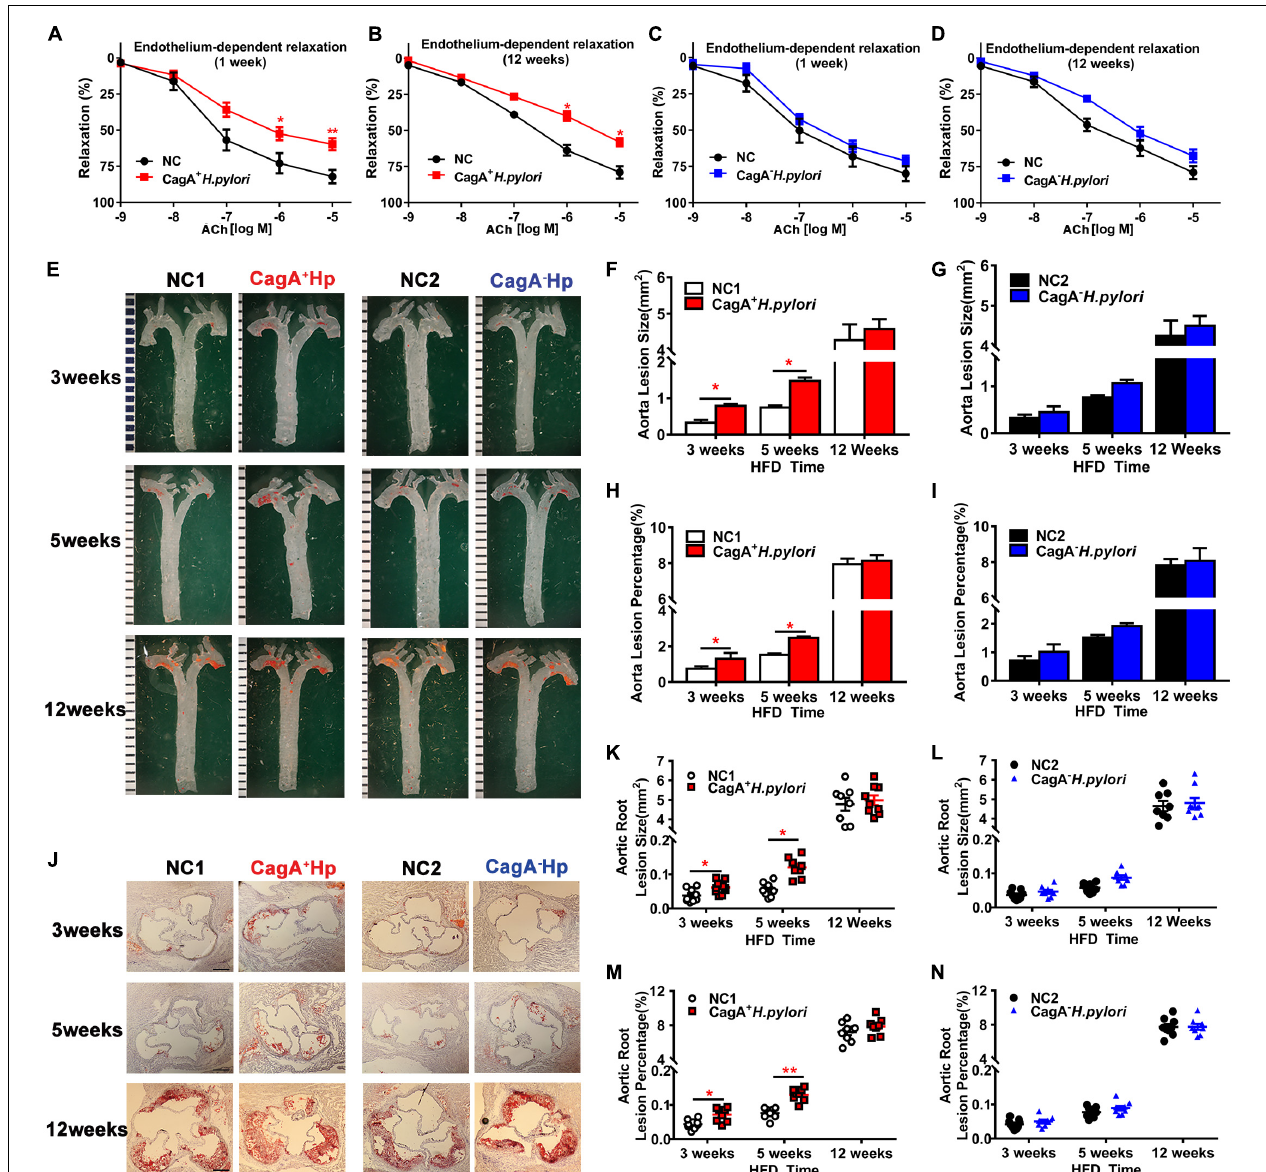
FIGURE 1 | CagA + Helicobacter pylori , not CagA − H. pylori infection, led to significant endothelial dysfunction, and promoted the development of atherosclerosis. ACh-induced aortic relaxation was significantly reduced in male C57BL/6 mice after 1 week (A) or 12 weeks (B) of CagA + H. pylori infection compared with control, while no change in ACh-induced aortic relaxation in mice with CagA − H. pylori infected was observed (C,D) ; (E–I) Representative images and quantification of Oil-red O-stained whole aorta of LDLR − / − mice with PBS, CagA + H. pylori or CagA − H. pylori infection after 3, 5, and 12 weeks of high-fat diet (HFD). (J–N) Representative images of cross-section histological and quantification of atherosclerotic lesions in aortic roots. NC(1/2): normal control; ACh: acetylcholine; CagA + Hp: CagA + H. pylori ; CagA − Hp: CagA − H. pylori . Data are presented as mean ± SEM. * P < 0.05, ** P < 0.01 by t -test, N = 8–10 mice for each group at each time